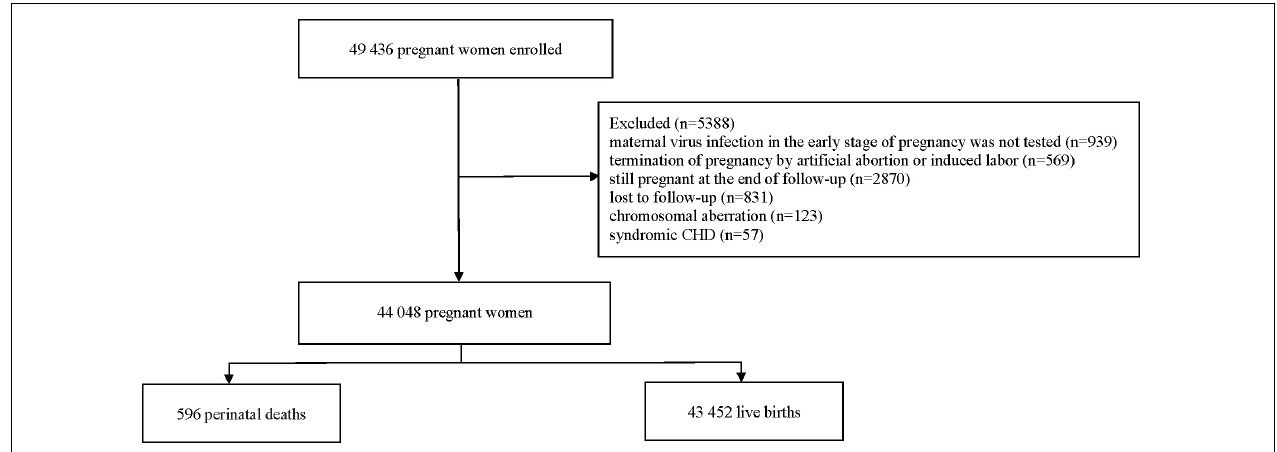
FIGURE 1 | Flowchart of the